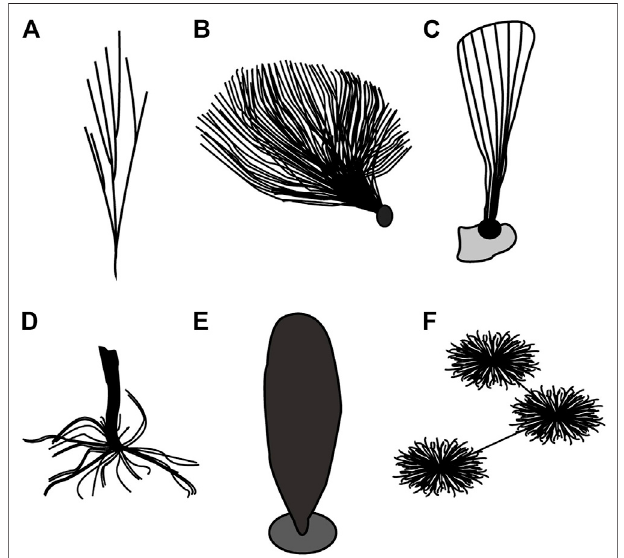
FIGURE 2 | Schematic illustration of Holdfast morphologies of benthic macroalgae from the Lantian and Miaohe biotas. (A) Tapered base of branching alga Doushantuophyton . (B) Globose holdfast of bush-like alga Anhuiphyton . (C) Composite globose with diffused organic mass of fan- like alga Flabellophyton . (D) Rhizoids of rod-like alga Baculiphyca . (E) Discoidalholdfastofrod-likealga Gesinella . (F) Horizontalrhizomeofbush-like alga Globusphyton